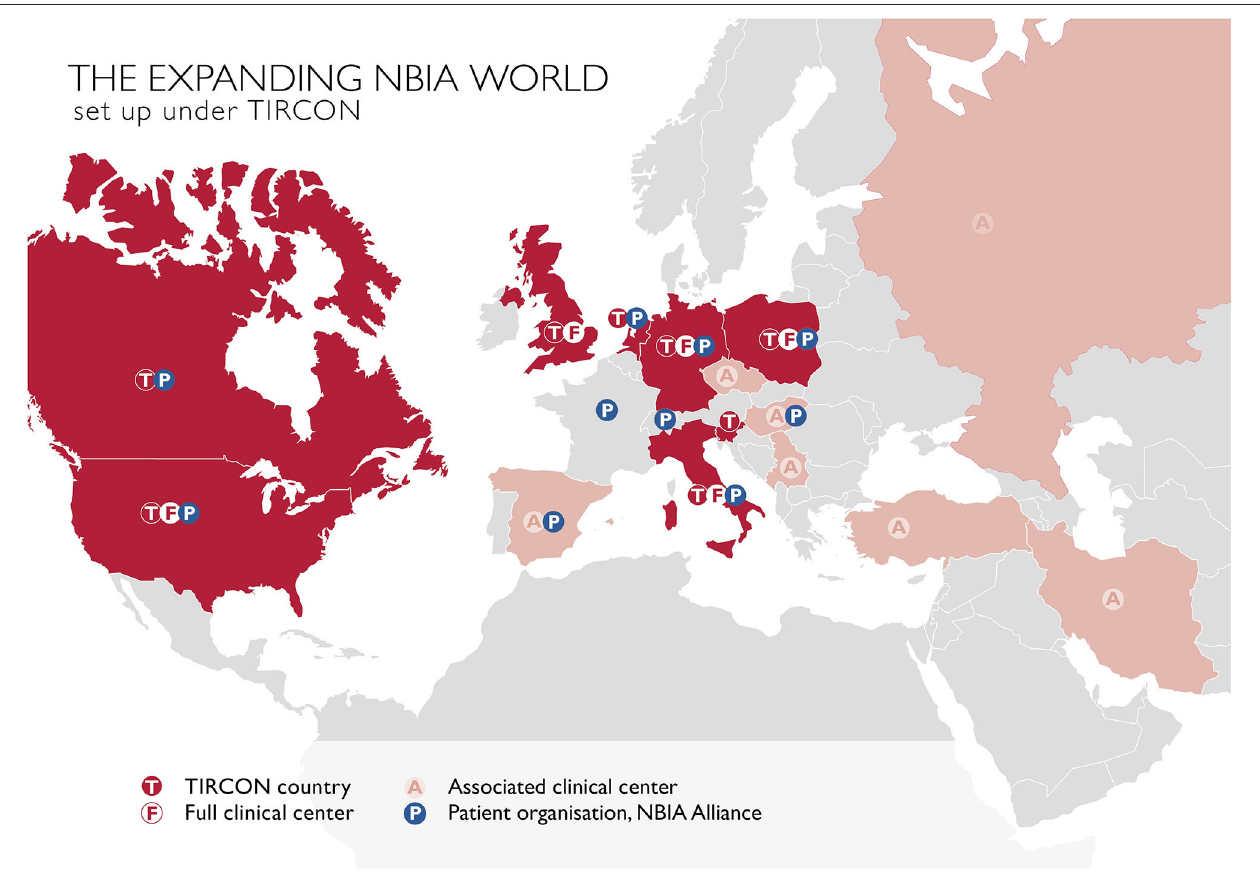
FIGURE 2 | TIRCON centers: T / F, initially involved TIRCON partners, full clinical centers and their respective countries; A, centers/countries, joined the network after the project start; P, patient